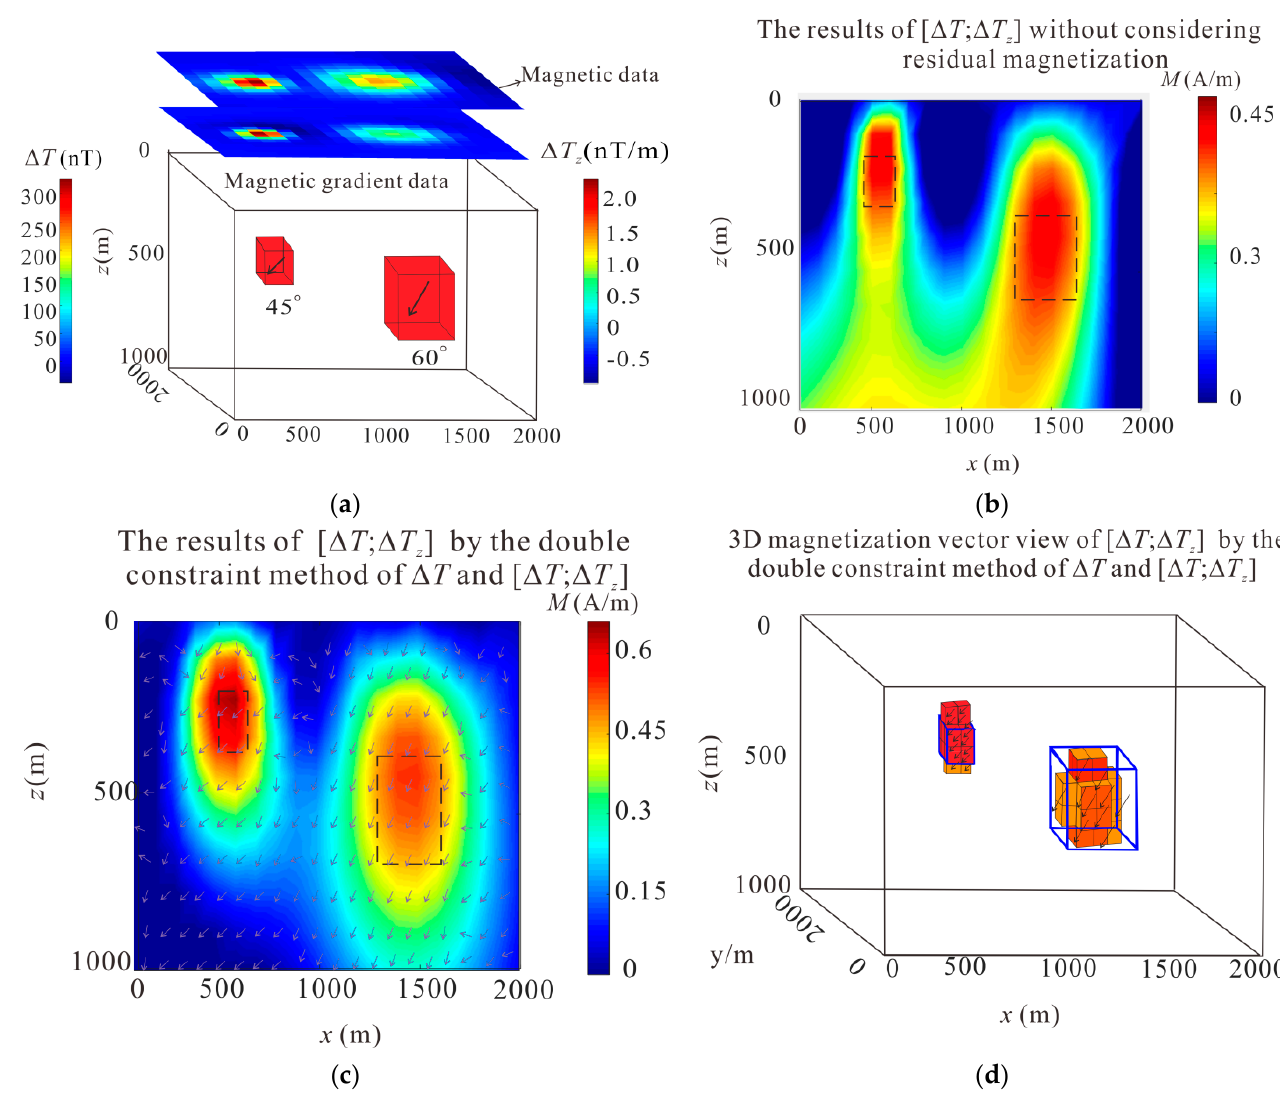
Figure 6. Models with different magnetization directions obtained by the data constraint and double constraints inversion method of CMG data and airborne magnetic data. ( a ) Airborne magnetic and its gradient anomaly; ( b ) the results of CMG data by the data constraint inversion method, with slices corresponding to y = 1000 m; and ( c , d ) the results of CMG data with Equation (8) by the double constraints inversion method and corresponding 3D magnetization vector view with a cutoff value 0.471 A/m, with slices corresponding to y = 1000 m.